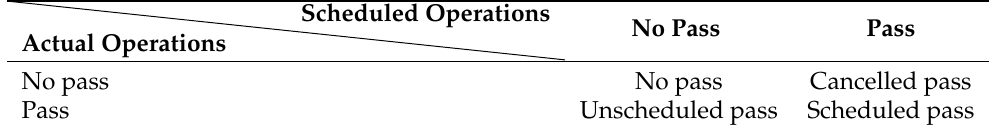
Table 1. Different types of train pass